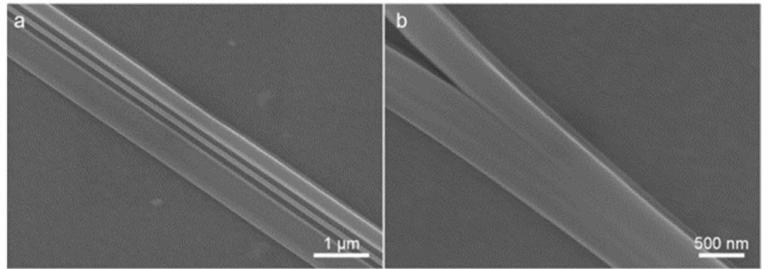
Figure 5. SEM images of FF microbelts: ( a ) three parallel dense packed belts; ( b ) microbelt’s